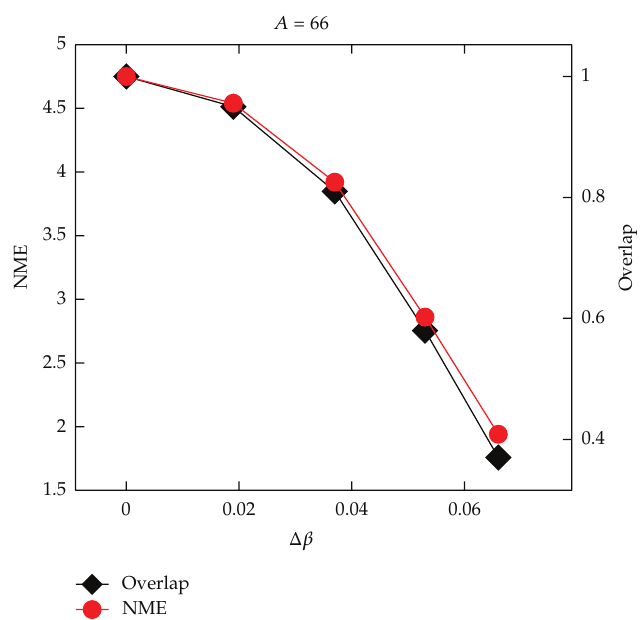
Figure 5: 66 Ge → 66 Se NME, M (cid:8) 0 ν , as a function of the di ff erence in deformation induced by an extra quadrupole interaction added to 66 Se.